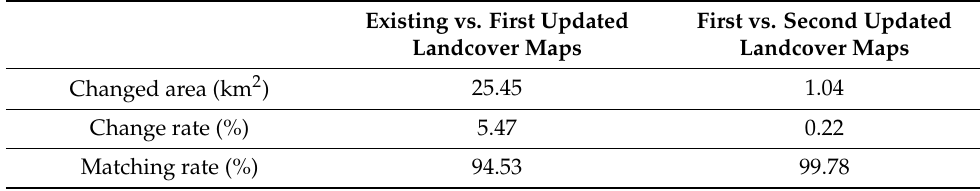
Table 6. Comparison of changed areas between the first and second update